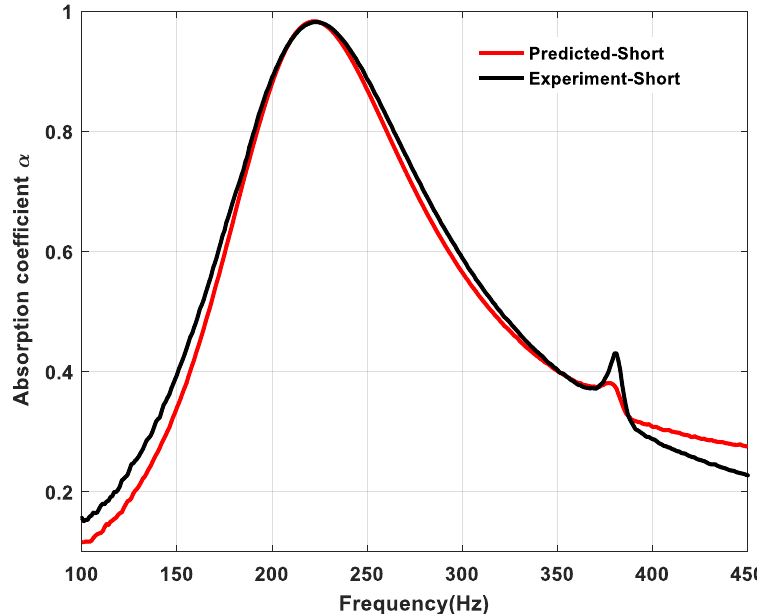
Figure 8. Short-circuit absorption coefficient